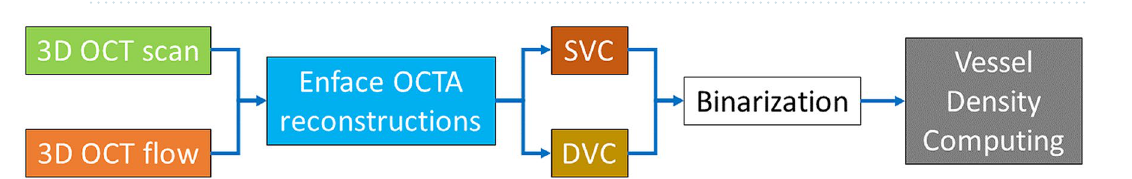
Figure 2. Workflow for computing vessel density OCTA metric. OCT optical coherence tomography, OCTA optical coherence tomography angiography, SVC superficial vascular complex, DVC deep vascular